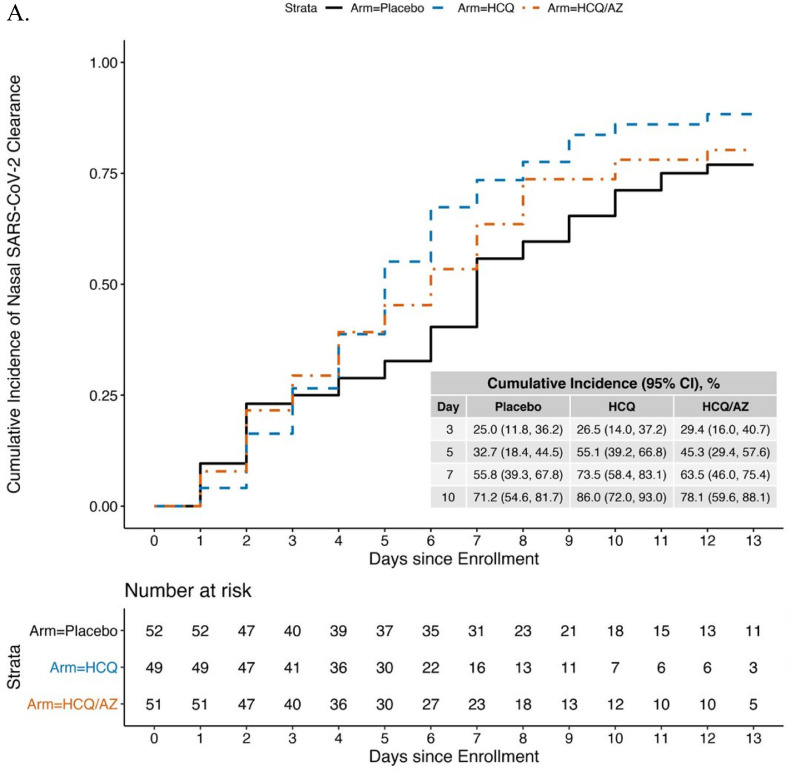
Kaplan-Meier curve showing time to viral clearance* over 14-days by study arm using a Ct cutoff of ≤40 (A) or ≤34 (B). *viral clearance defined as 2 consecutive swabs without SARS-CoV-2 detected.